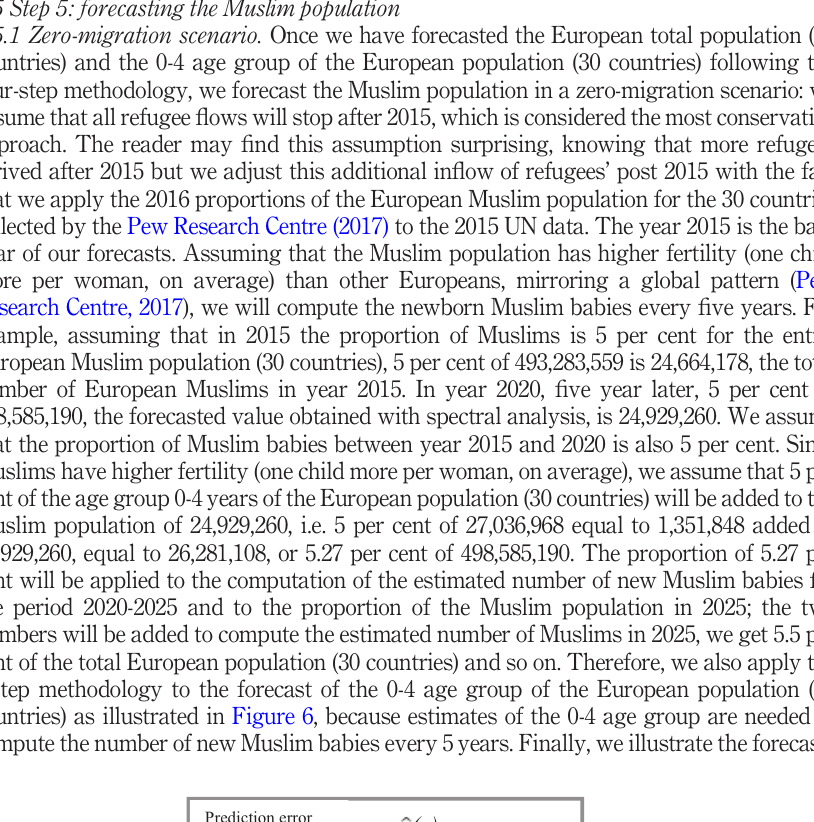
Figure 4. Prediction error fi